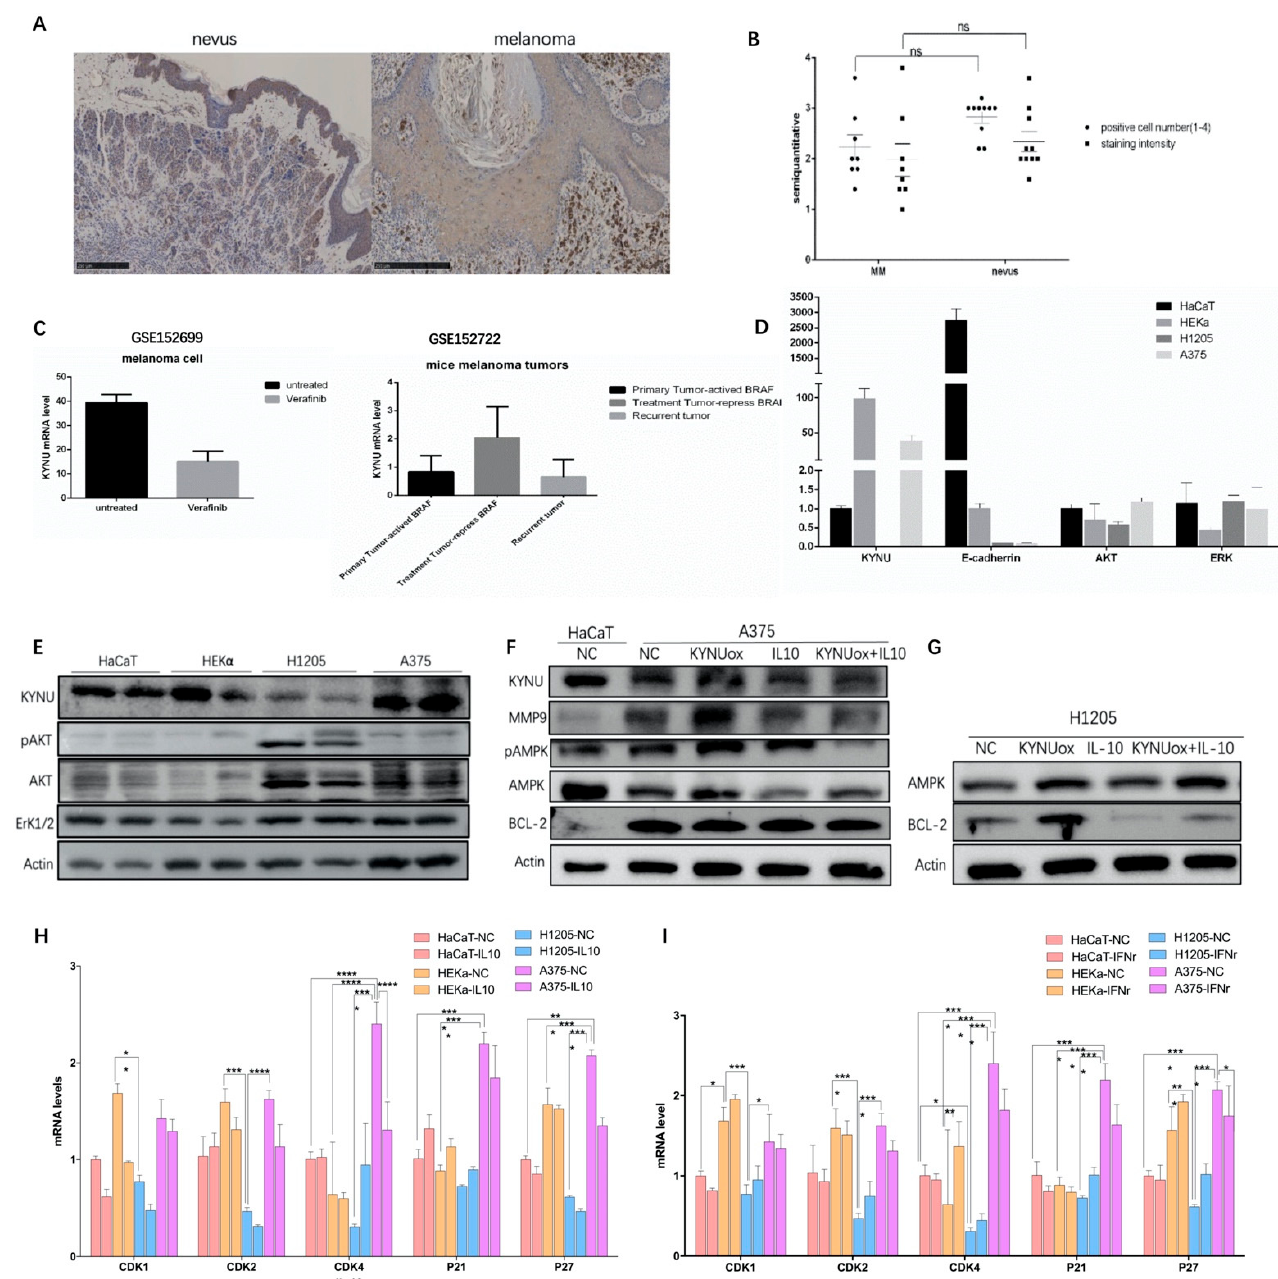
Figure 4. Expression of KYNU and KYNU regulatory factors in melanoma: ( A , B ) immunohisto- chemical staining of KYNU in intradermal nevi and melanoma patient tissues, melanoma n = 8, intradermal nevi n = 9, scale bar = 250 μ m. Significance was determined by one-way ANOVA test, ns ( p > 0.05); ( C ) changes in the expression of KYNU regulated by BRAF in melanoma cells and mouse melanoma tissues; ( D , E ) protein and mRNA expression levels of KYNU and signaling pathways in different keratinocyte and melanoma cell lines; ( F , G ) metabolism-, apoptosis-, and invasion-related protein changes in A375 and H1205-lu melanoma cells stimulated by KYNU overexpression or IL-10; ( H , I ) mRNA expression of cyclin-dependent protein kinases and inhibitors in HaCaT, HEK α , H1205-lu, and A375 cell lines induced by IL-10 and IFN- γ . * p < 0.05, ** p < 0.01, *** p < 0.001, and **** p < 0.0001 according to ordinary one-way ANOVA compared to controls.